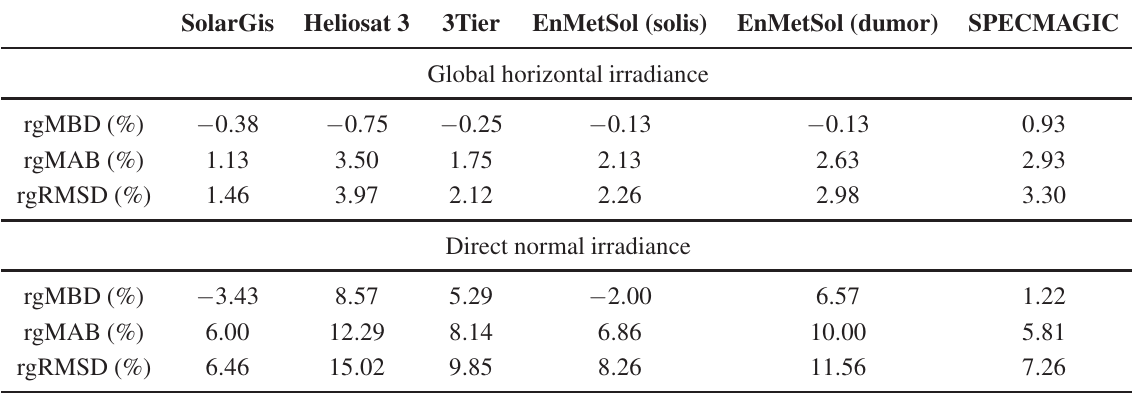
Table 8. General statistics for the validation of global horizontal and direct normal irradiance estimation, Ineichen, 2011 [35], using only the 8 stations that all validations have in common. SolarGis Heliosat